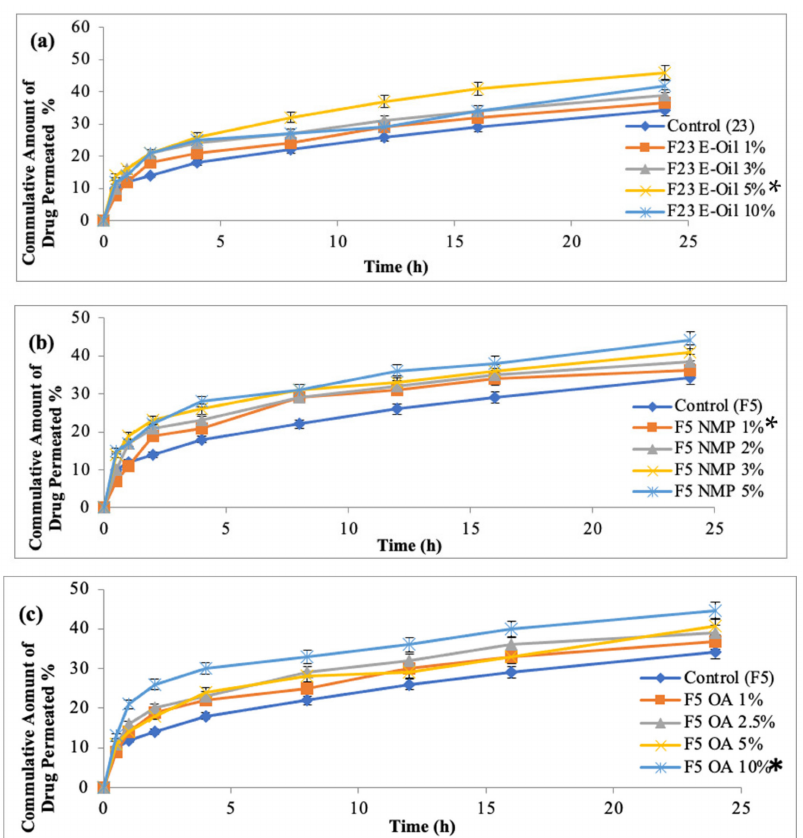
Figure 9. Permeation profiles of methotrexate from formulated patches using ( a ) E-Oil, ( b ) NMP and ( c ) OA as penetration enhancer. Data are expressed as mean ± SD; n = 3. One-way ANOVA followed by post hoc Tukey test ( p < 0.05). (* p <0.05).